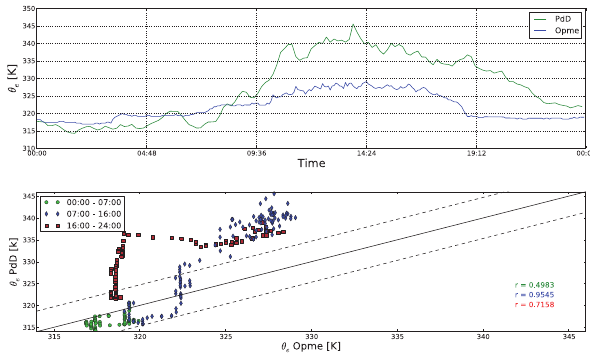
Fig. 8. Evolution of equivalent potential temperature, θ e at both sites (upper panel) and the correlation between the two sites (bottom panel) in case of nucleation at Opme site (12 August 2007). On the bottom panel, the lines represent the uncertainty boundaries of the θ e (1:1)